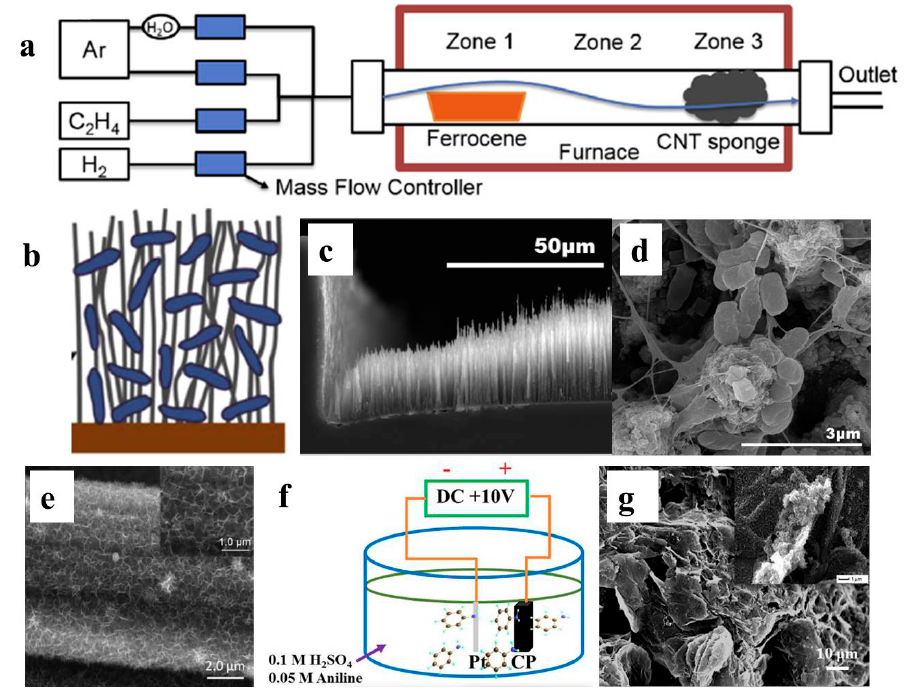
Figure 2. ( a ) Schematic of porous 3D CNT sponge fabrication by CVD [59]; ( b ) Schematic of biofilm attachment in CNT matrix with long and loose structure [78]; ( c , d ) SEM images of vertically aligned, forest like MWCNT deposited on silica wafer chamber via CVD [77]; ( e ) SEM image of porous MnO 2 3D frame in-situ growth on carbon paper via electrochemical reduction [79]; ( f , g ) Schematic and SEM image of in-situ fabricated graphene/PANI composite electrode on graphite paper surface [81]. Reproduced with permission from Elsevier, American Chemical Society and Wiley.